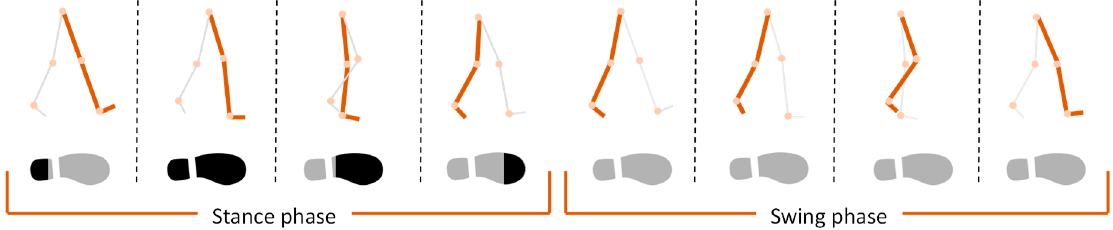
Figure 1. Gait characteristics and stance-phase detection.